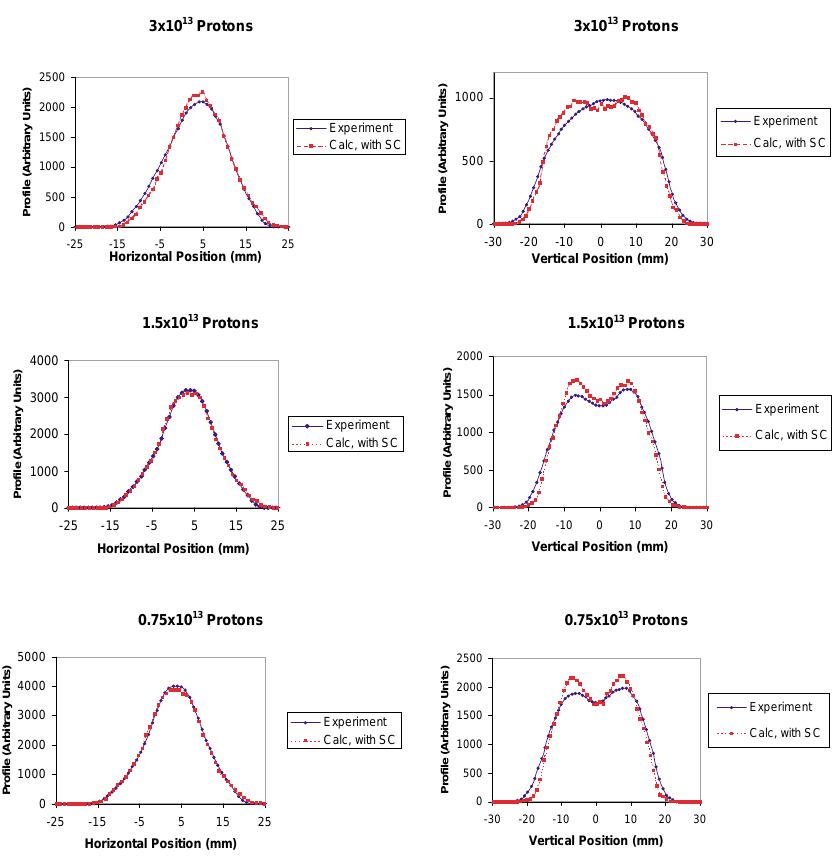
FIG. 2. (Color) Comparison of the calculated and measured horizontal and vertical distributions for three accumulated beam intensities, with vertical painting. Space charge forces are included in the calculations.